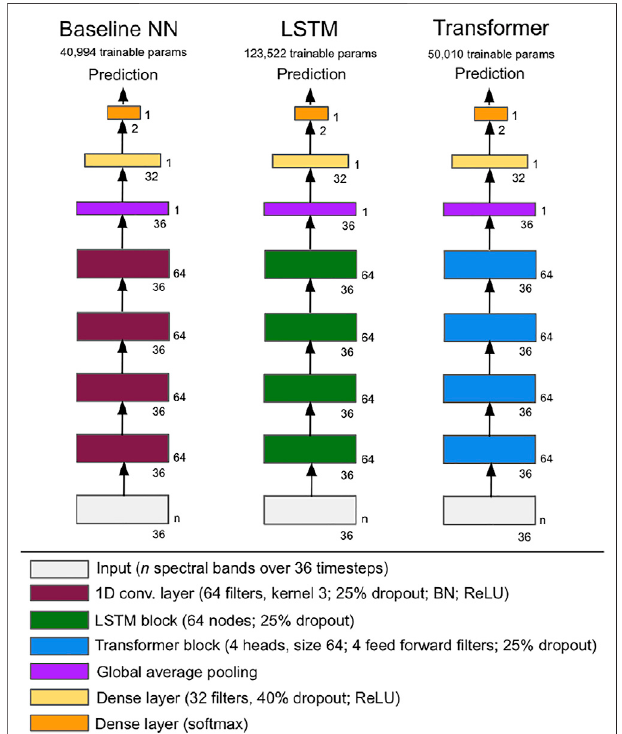
encoding blocks differ across